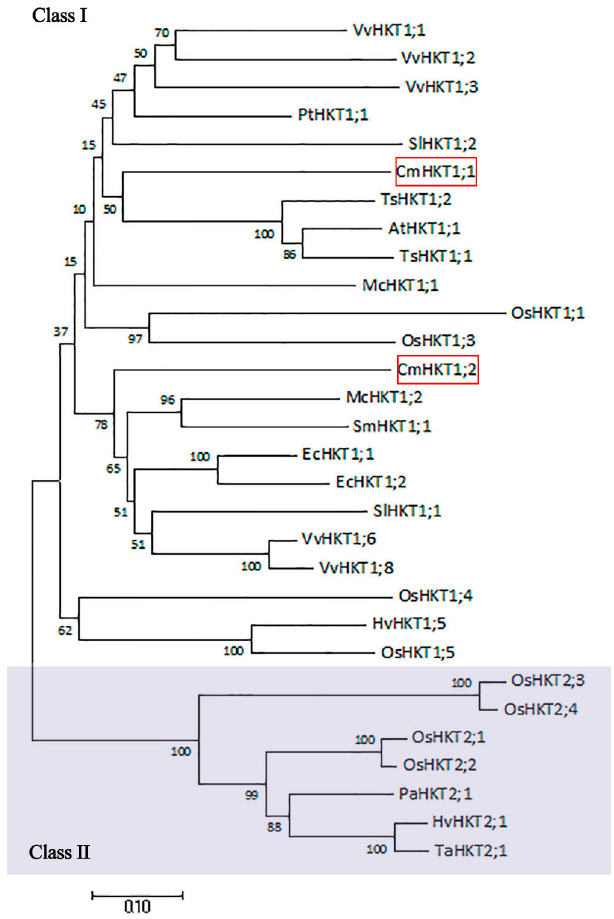
Figure 2. Phylogenetic relationship between pumpkin HKT proteins and other plant HKTs. The evolutionary history was inferred using the neighbor-joining method. Evolutionary analyses were conducted in MEGA7 [30]. The scale bar corresponds to a distance of 0.10 substitutions per site. Bootstrap values are indicated adjacent to the corresponding node. The protein accession numbers as listed in the GeneBank database are: AtHKT1;1 NP_567354; EcHKT1;1 AAF97728; EcHKT1;2